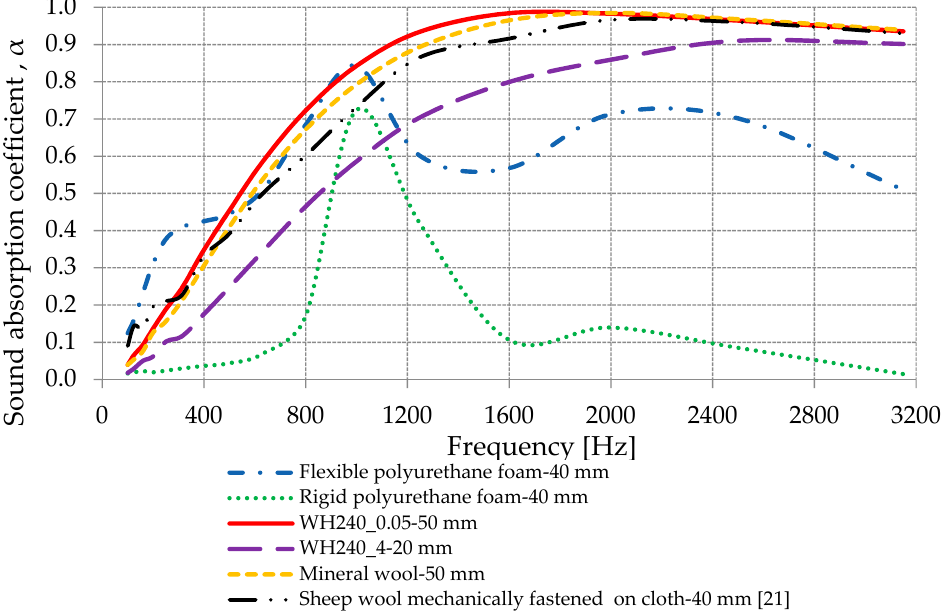
Figure 11. Variation in the acoustic absorption coefficient for WH240_0.05, WH240_4, flexible polyurethane foam, rigid polyurethane foam, and mineral wool.